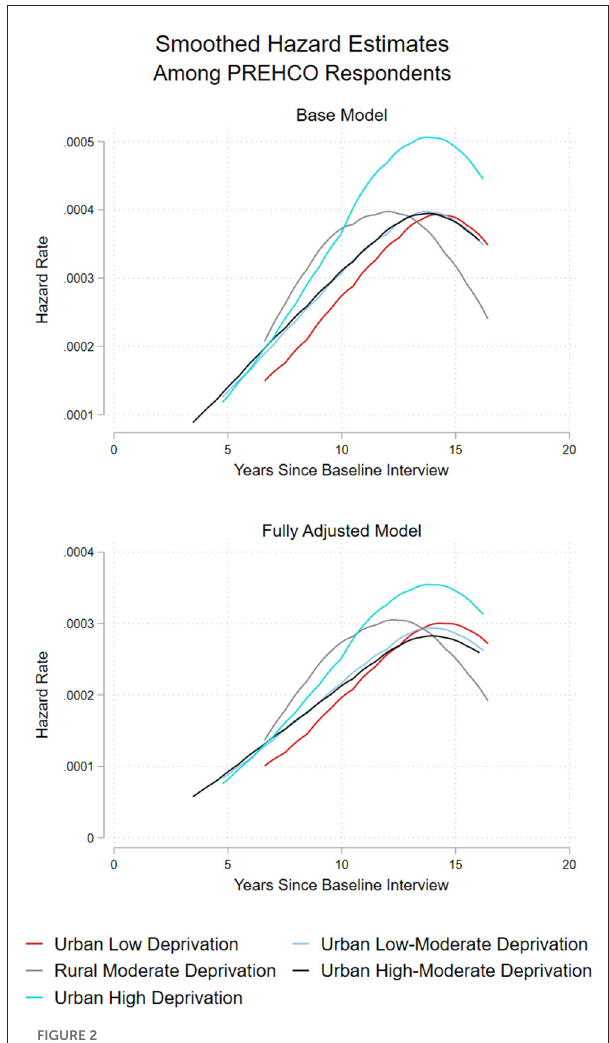
FIGURE2 Smoothed hazard estimates of all-cause mortality by neighborhood cluster.